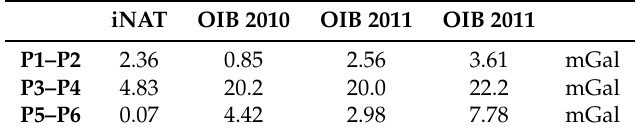
Table 7. Difference in gravity disturbance at the intersection points between the P7-KAGA line and the three OIB lines.